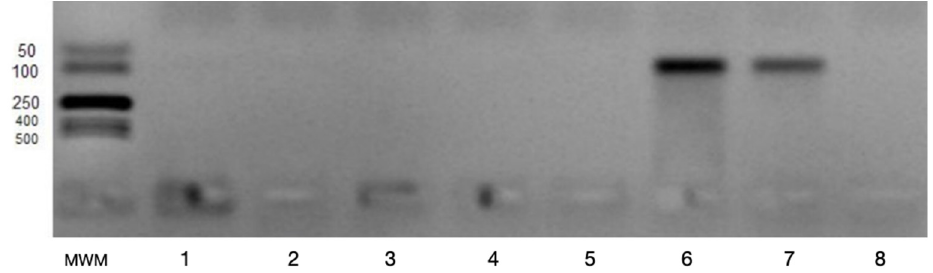
Figure 2. Example of electrophoretic separation of PCR products for VEGF-B, MWM-molecular weight marker (50–500 bp); 1–6-samples (84 bp); 7-positive control; 8-negative control.